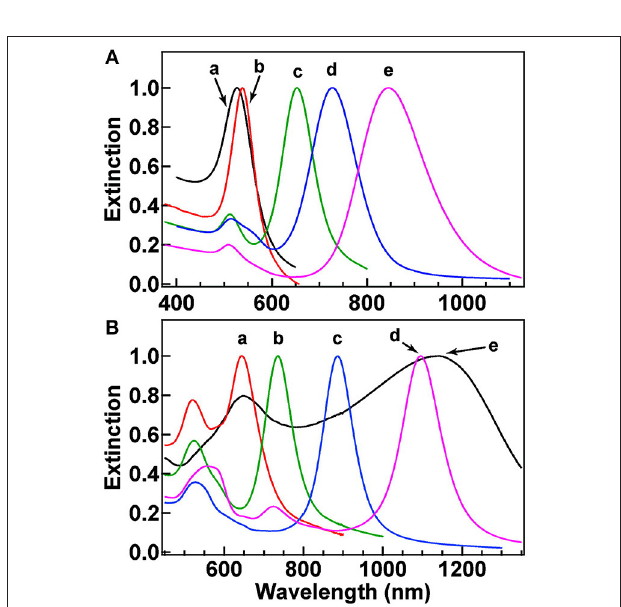
FIGURE 5 | Normalized extinction spectra of the gold nanostructures. (A) Spectra a–e correspond to nanospheres (aspect ratio = 2.4 ± 0.3), nanocubes (aspect ratio = 3.4 ± 0.5), and nanorods with aspect ratios of 4.6 ± 0.8. (B) Spectra a–d correspond to nanobipyramids with different aspect ratios (as shown 1.5 ± 0.3, 2.7 ± 0.2, 3.9 ± 0.2, and 4.7 ± 0.2, respectively) and nanobranches (spectra e). Re-printed with permission from American Chemistry Society Publications 2008 (Chen et al.,